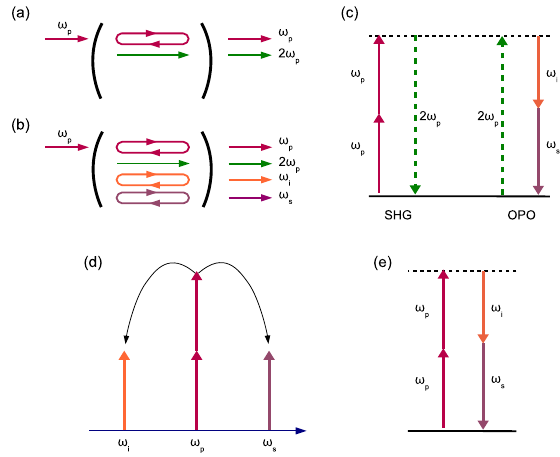
Figure 1: Internally pumped OPO in intracavity SHG. (a) fundamental and second harmonic fields in a singly resonant SHG cavity; (b) for suflcient SH power an internally pumped nondegenerate OPO oc- curs, clamping the SH power to a constant level; (c) energy-level di- agram for the sequence of second harmonic generation and optical parametric oscillation: in this regime, there is no net SH generation; (d) in the subharmonic range, around the fundamental frequency,